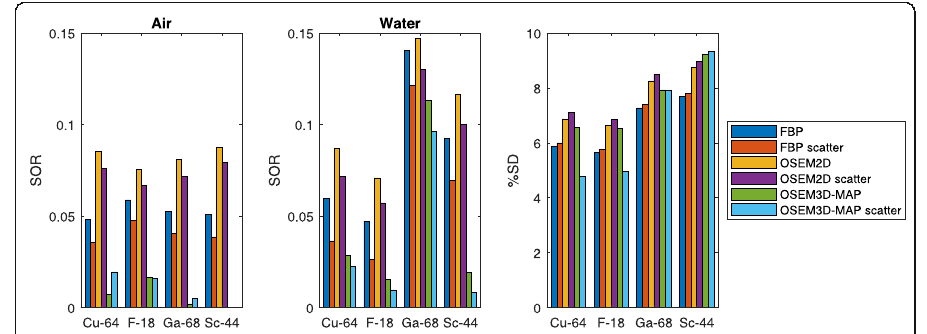
Fig. 3 Impact of radionuclide and reconstruction algorithm on %SD and SOR in air and water. All data were acquired with the same number of counts. Both the uncorrected and scatter corrected values are presented for comparison